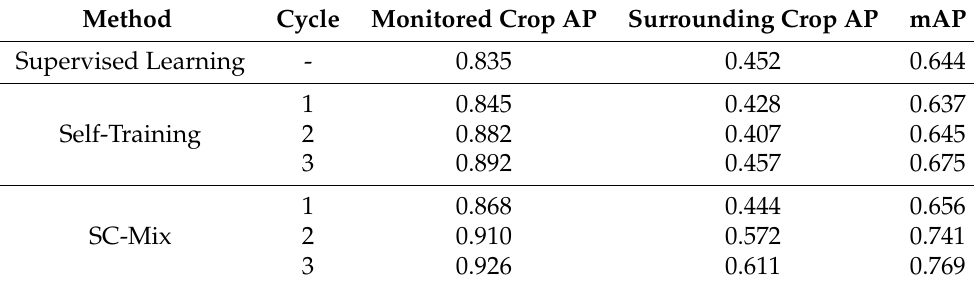
Table 2. Results of AP performance for each category and mAP.